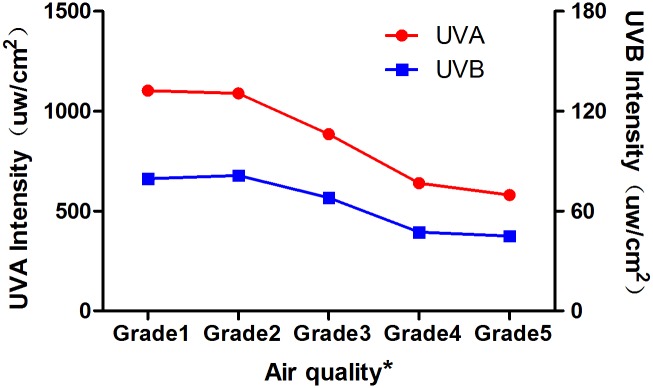
Ultraviolet intensity in 5 air quality grades.* The air quality was divided into five grades based on the AQI: grade 1, 0–50, Excellent; grade 2, 51–100, Good; grade 3, 101–150, Mild Pollution; grade 4, 151–200, Moderate Pollution; grade 5, 201–300, Serious Pollution. As air pollution increased, the ultraviolet intensity decreased.